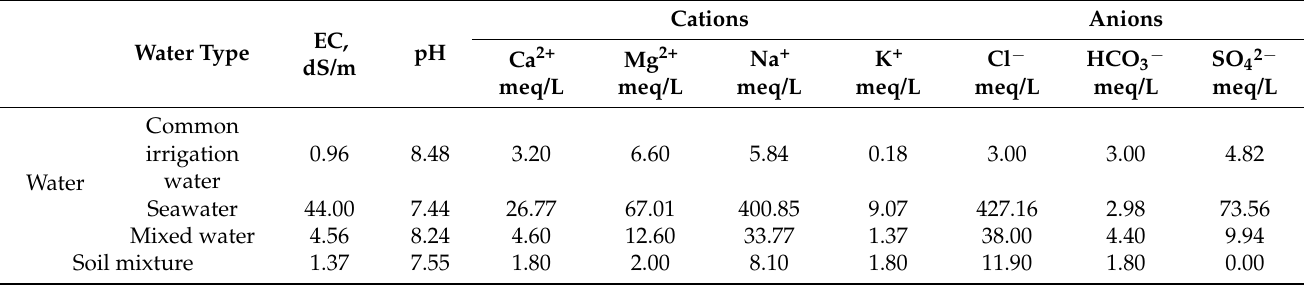
Table 1. Chemical analysis of water and soil mixture including EC, pH, anions and